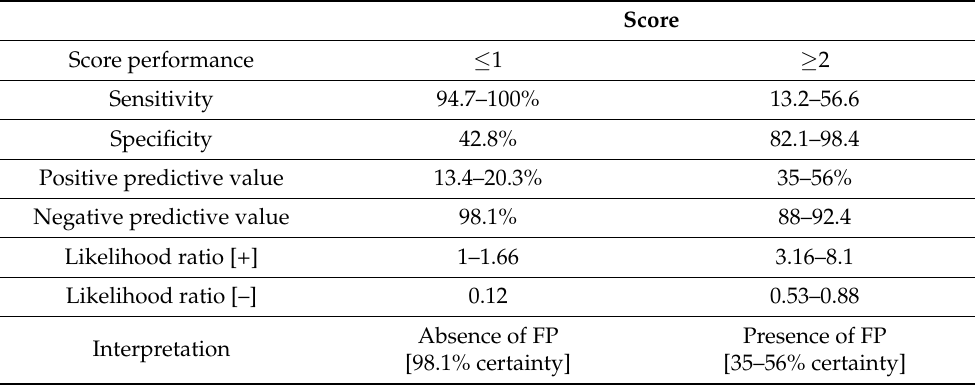
Table 3. Predictive value of the scoring